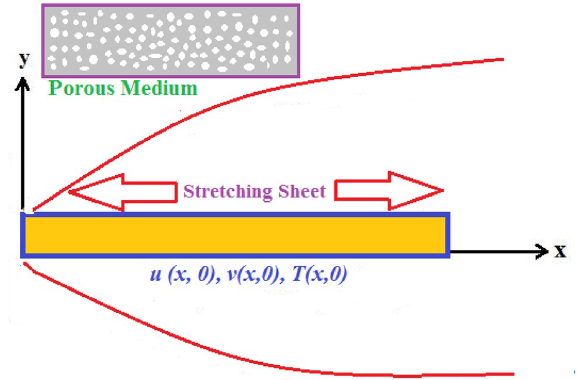
Figure 1. Flow sketch presentation.